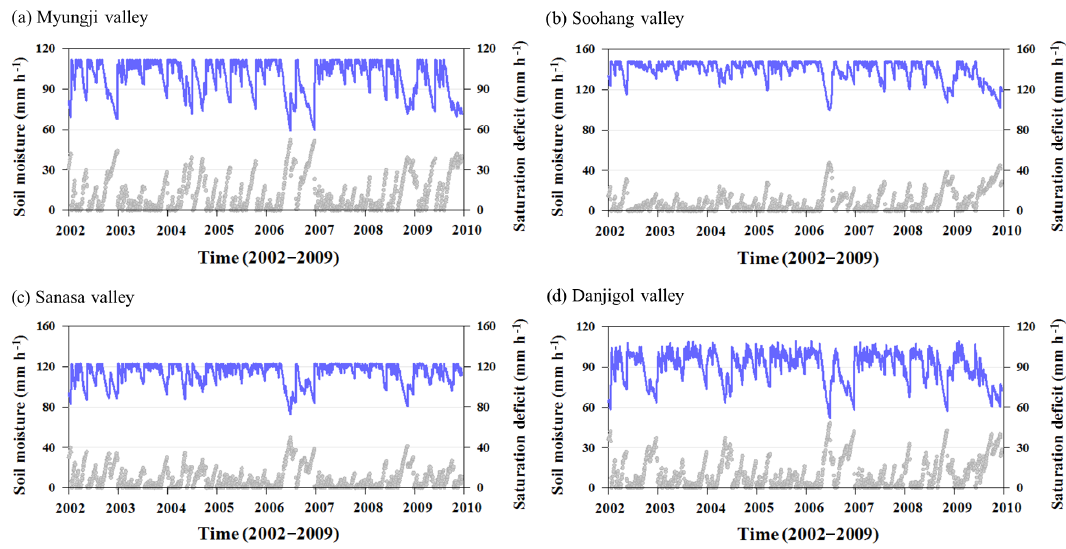
Figure 6. Soil moisture and soil moisture deficit in selected sub-basins. The blue and grey lines represent soil moisture and saturation deficit,